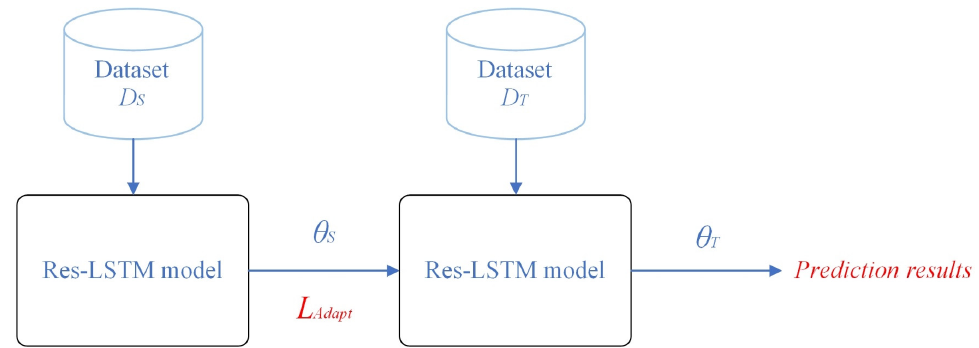
Figure 3. The training architecture based on transfer learning proposed in this paper.